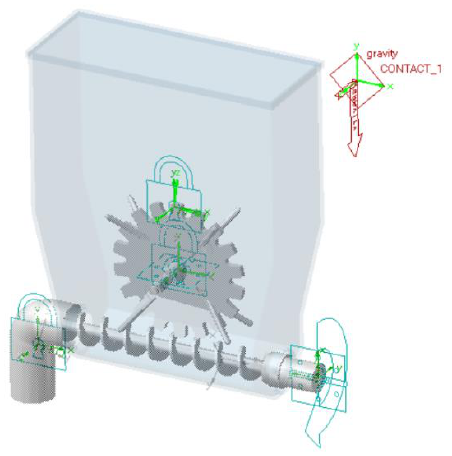
Figure 7. Virtual prototype model of the horizontal screw conveyor.